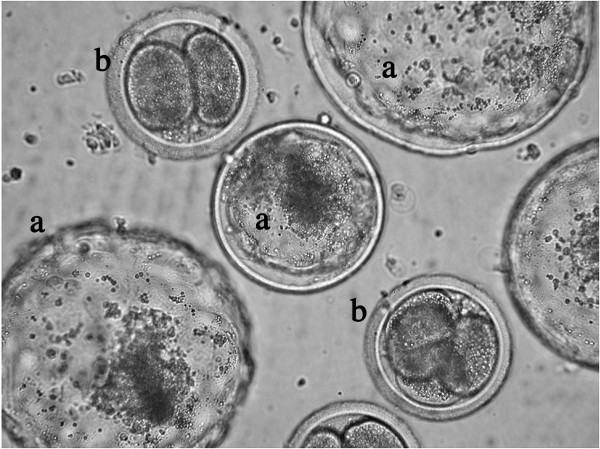
Appearance of 2–4 cell arrested embryos at day-8 post insemination. Morphological appearance of day-8 in vitro produced bovine embryos. Embryos at this time after in vitro fertilization usually reached the blastocyst stage (a), while arrested embryos still appeared as morphologically normal 2–4 cell embryos (b). (Magnification: 400×).